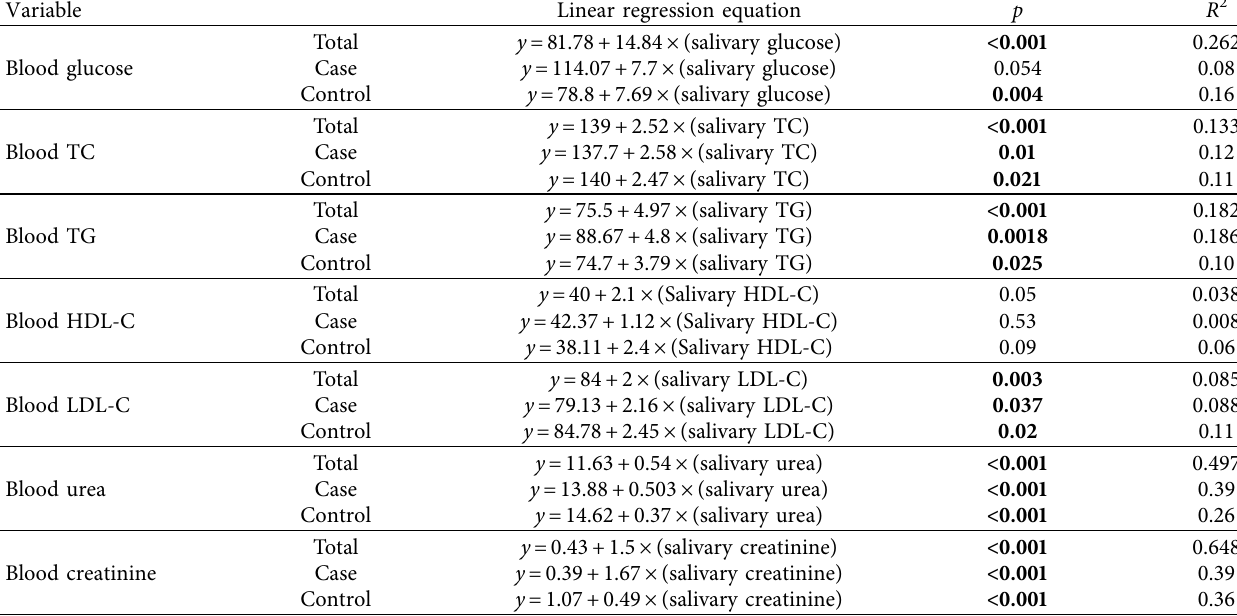
Table 5: Table showing linear regression analysis of salivary and blood variables in total population.